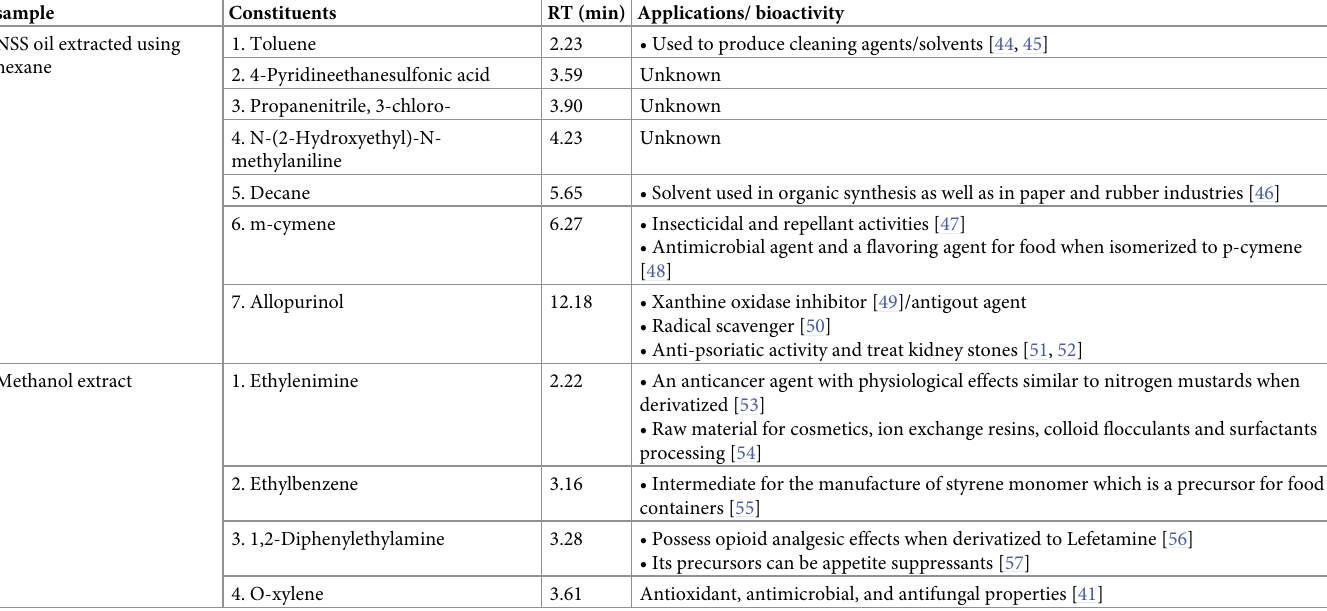
Table 3. Major chemical constituents identified in N . sativa seeds extracts (oil extracted with hexane and methanol extract) and their known medicinal applications or bioactivity. sample